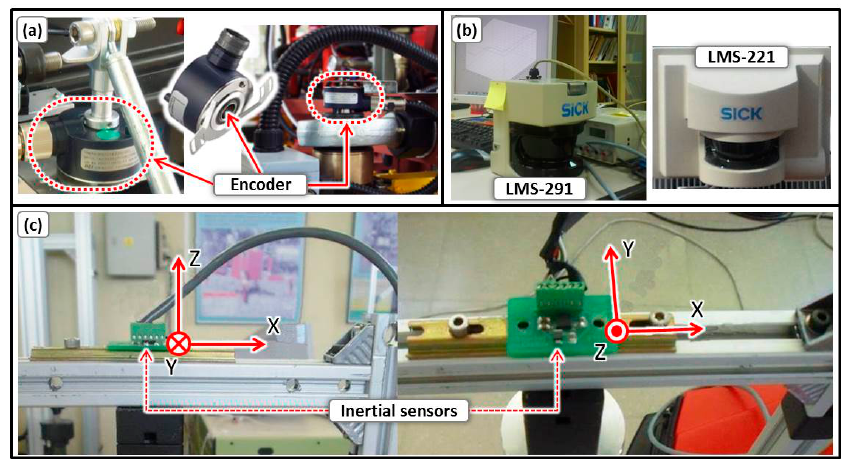
Figure 2. Some sensors used in the proposed experimental platform. ( a ) Industrial-grade absolute optical encoders; ( b ) LIDAR sensors being tested in the lab; ( c ) MEMS inertial sensor testing.